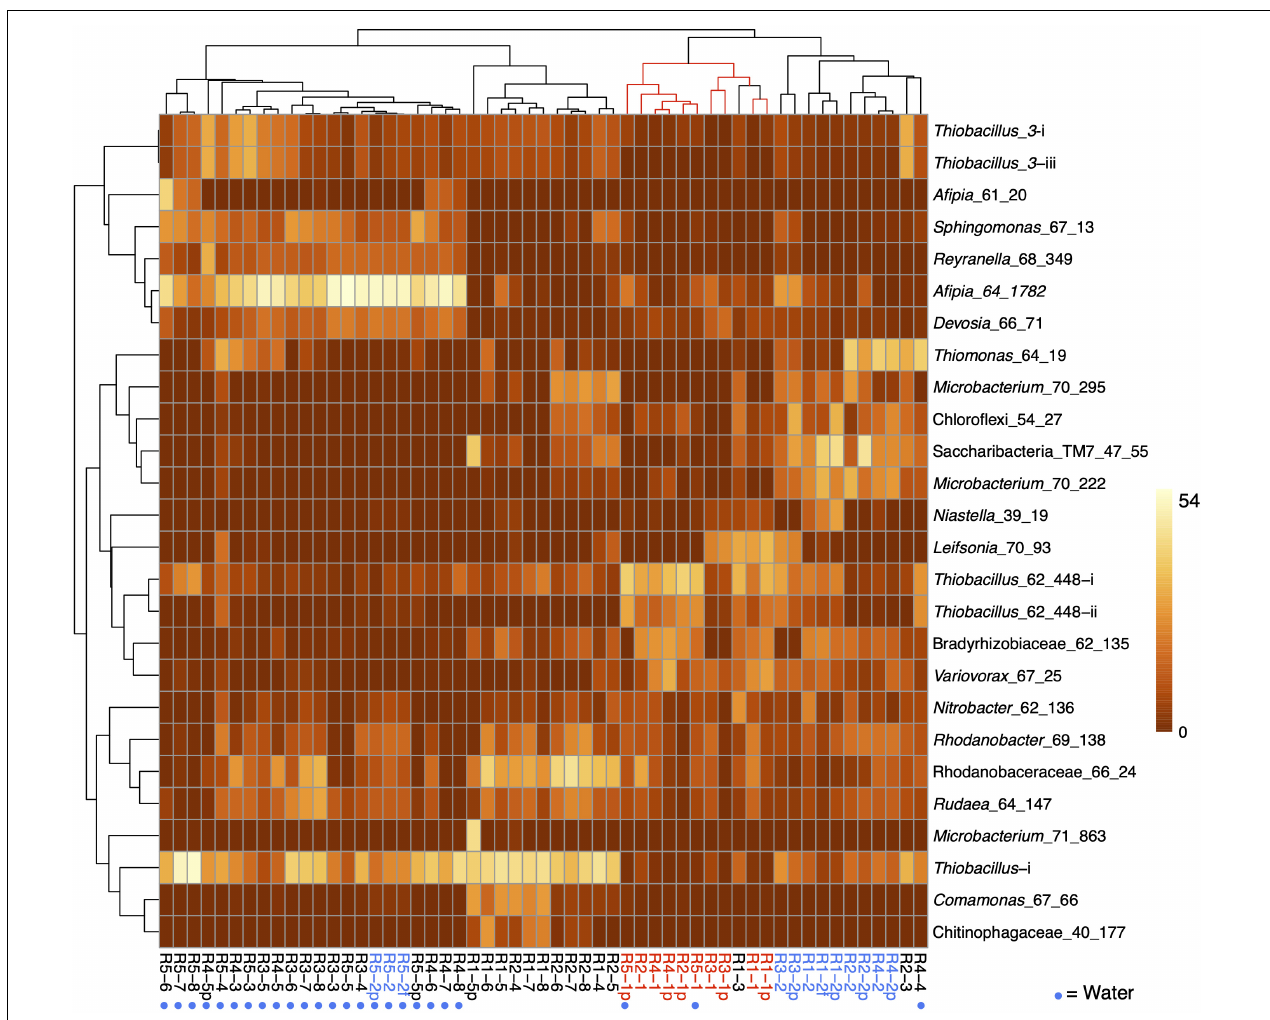
FIGURE 3 | Heat map showing the clustering of the patterns of abundance of the 26 most abundant organisms in R1 (molasses SCN ramp reactor) and/or R5 (water SCN ramp reactor). The plot is log(x + 1) transformed with no row centering and includes some planktonic (p) and floc (f) samples as well as biofilm samples. Red text and lines indicate the first samples from the five reactors, and blue text indicates the second samples from these reactors. See Figure 2A for the pattern of abundance of these organisms over samples and reactors and Figure 2B for the full names of all genotypes. Note that, with the exception of the starting communities (Rx-1) and R4-4, communities in the reactors not receiving molasses cluster